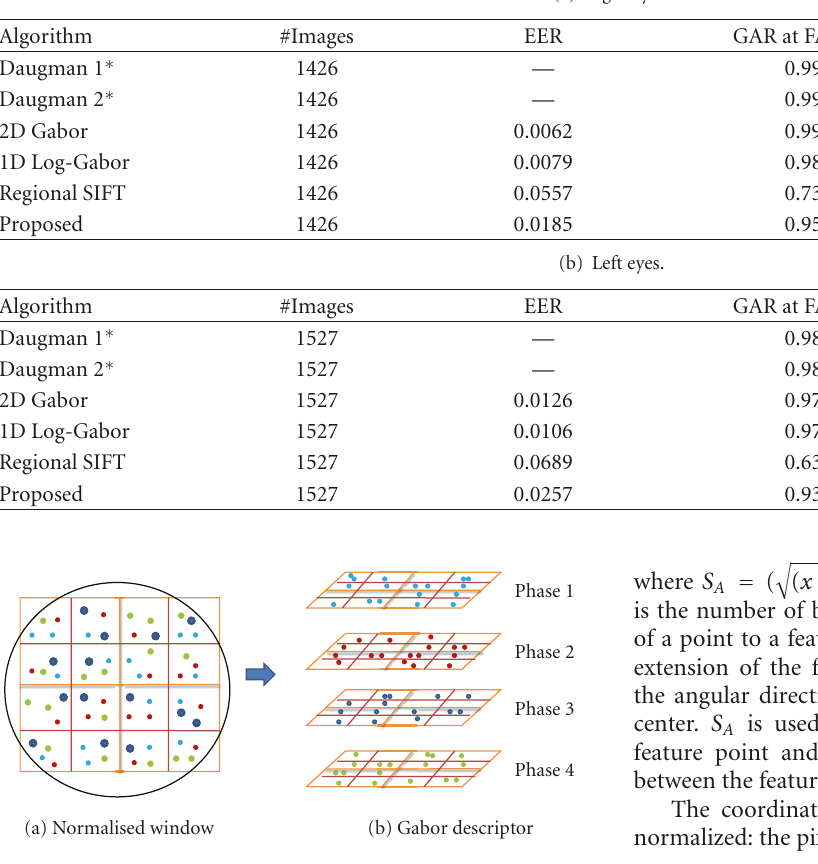
Figure 6: The process of a Gabor descriptor. The di ff erent colors in the left image shows that the Gabor filter results show they are in di ff erent phase layers.